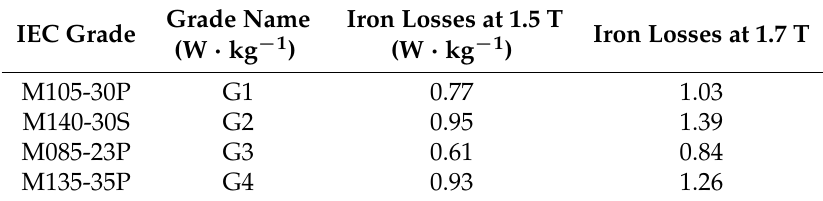
Table 1. Characteristics of the analyzed electrical